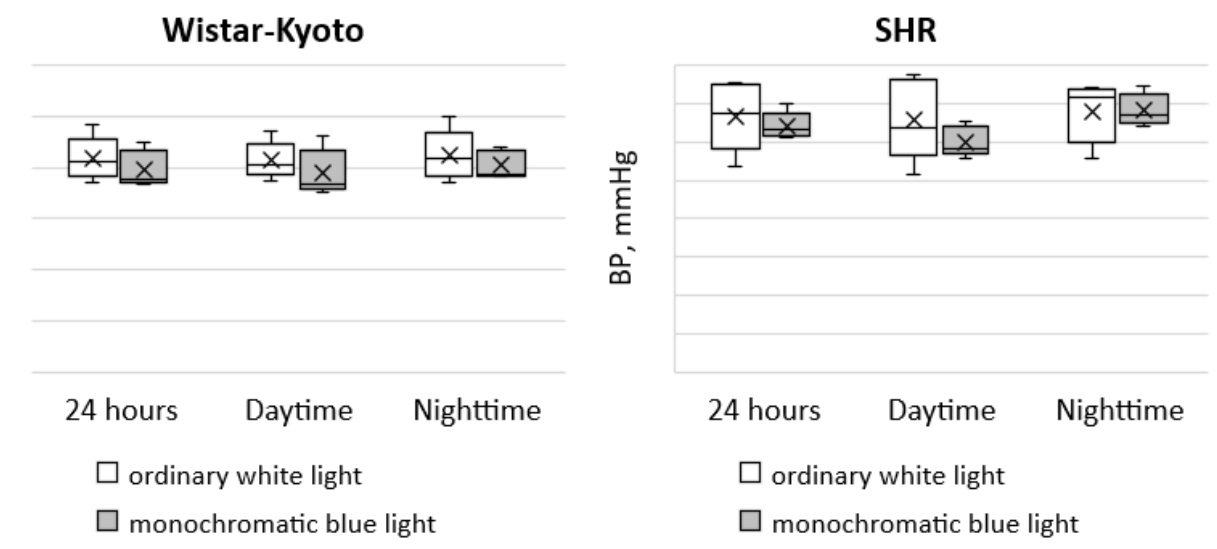
Figure 2. Indicators of the telemetric monitoring of DBP in Wistar–Kyoto and SHR rats under the standard light pattern (12 h:12 h) with ordinary white light and monochromatic blue light.